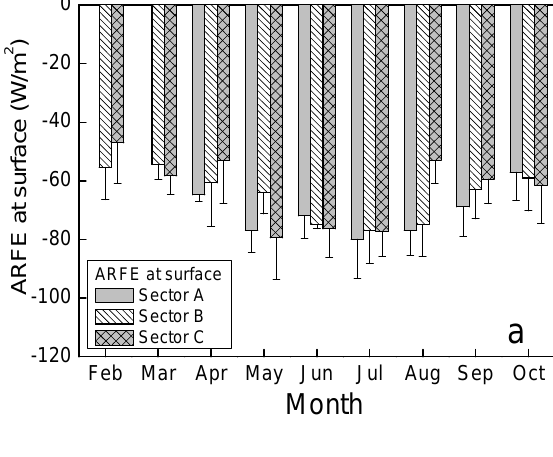
Fig. 8. Computed aerosol radiative forcing at TOA (open symbols) and at surface (full symbols) as a function of solar zenith angle for the sectors A, B and C during desert dust events occurred at Granada from 2005 to 2010. The error bars correspond to standard deviation.